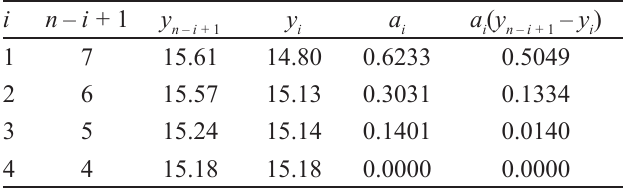
, for the ofloxacin 1